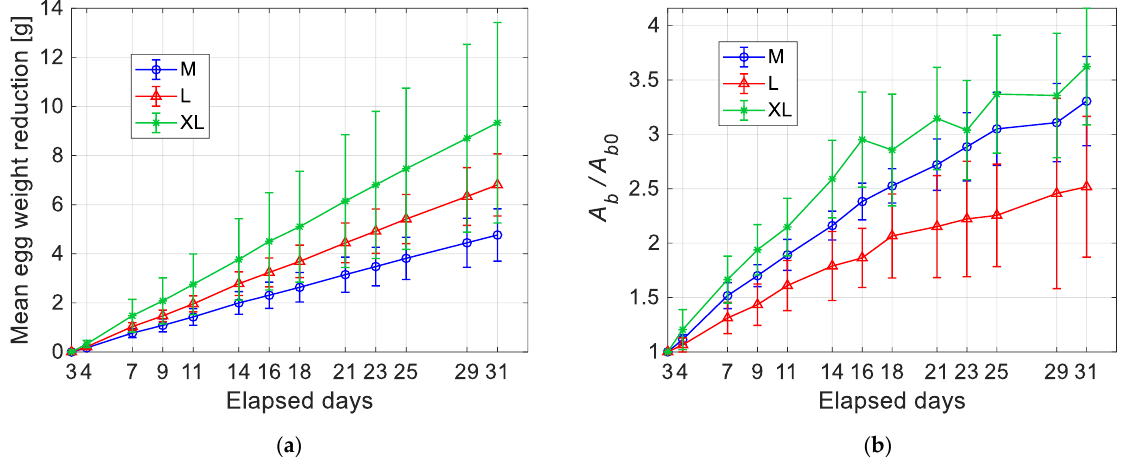
Figure 13. Mean values of the egg weight reduction ( a ) and increment of the mean values of the normalized air chamber area ( b ) vs. elapsed days for different egg categories (M, L, XL).